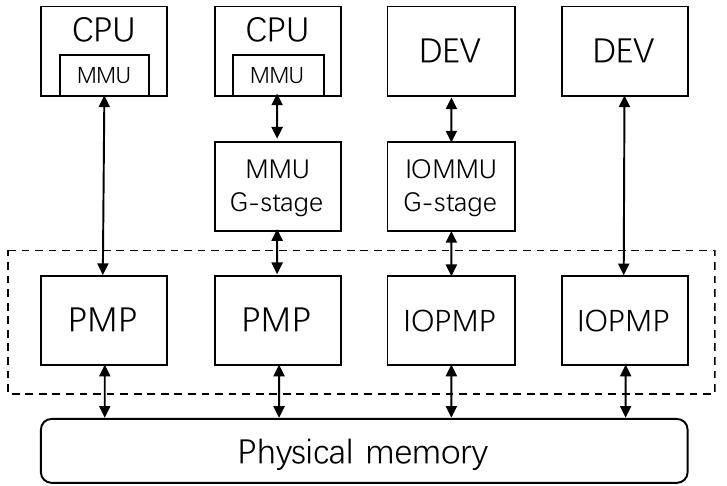
Figure 6. PMP and IOPMP in RISC-V